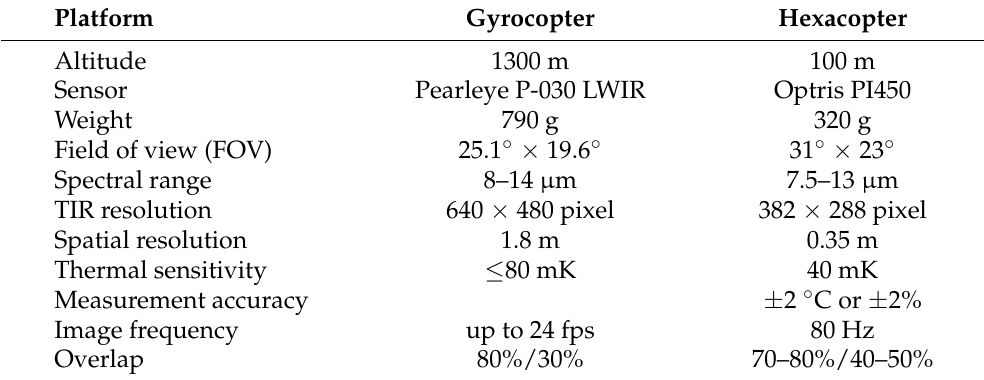
Table 1. Specifications of the TIR sensors and image acquisition. The overlap is measured along-track and between flight